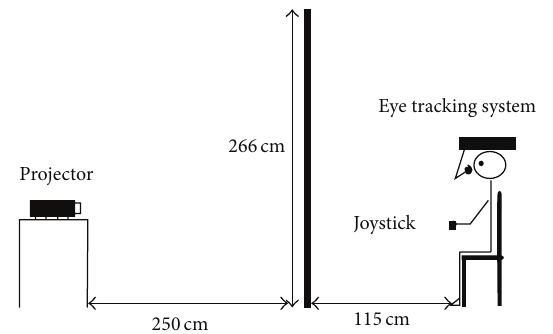
Figure 2: A lateral view of the experimental setup.